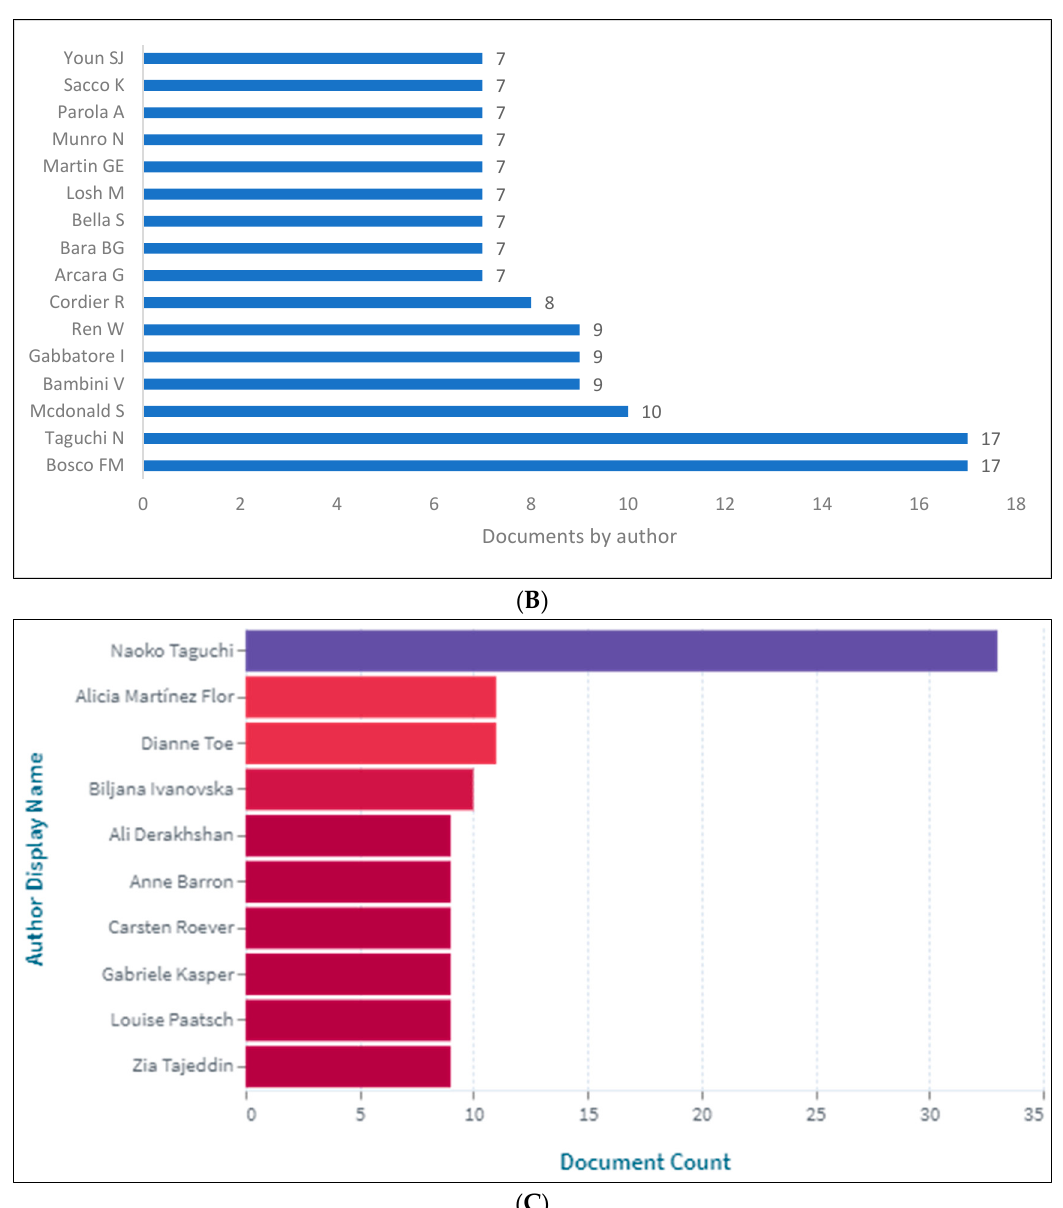
Figure 7. Pragmatic language development knowledge production size by author: ( A ) Scopus; ( B ) WOS; ( C ) Lens.